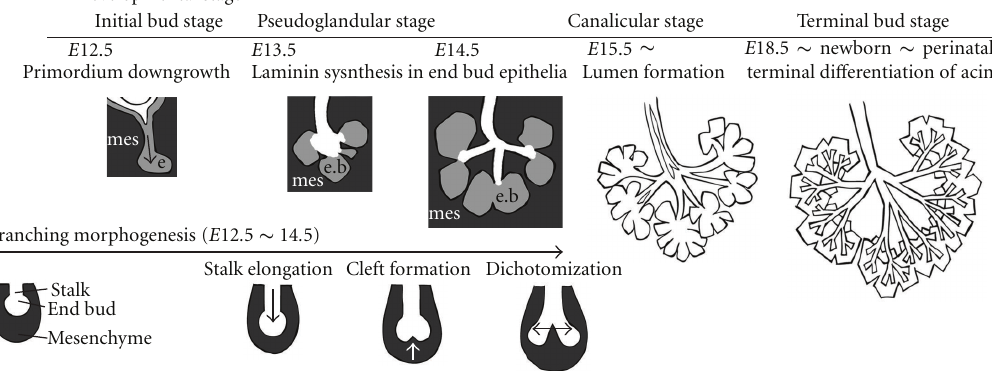
Figure 1: Brief overview of salivary gland development in mice. Schematic diagram of the 4 stages of salivary gland development: initial bud, pseudoglandular, canalicular, and terminal bud stage. Laminin-producing epithelia in end buds are indicated in light grey (pseudoglandular stage). Laminin-producing epithelia are only present in end buds but not in the stalk portion during BrM. A schematic diagram of the 3 steps in branching morphogenesis, stalk elongation, cleft formation, and dichotomization is also shown. Salivary mesenchyme is indicated in dark grey, and epithelia in white. See text for explanation. Abbreviations: mes: mesenchyme; e: epithelium; e.b: epithelial